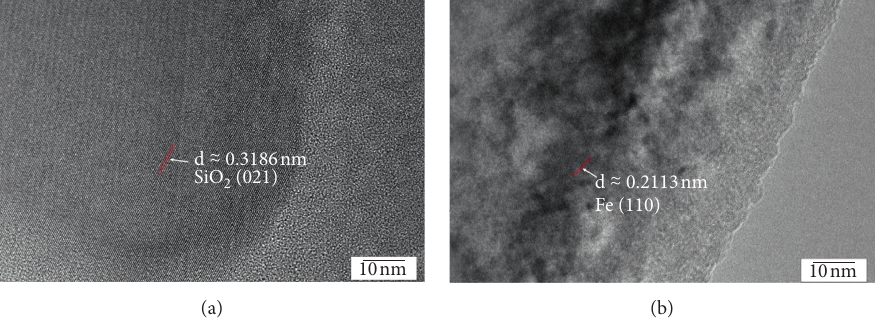
Figure 8: High-resolution transmission electron microscopy (HRTEM) image and corresponding SAED pattern of the as-cladded 2.25Cr1Mo0.25V sample made by WAAM: (a) inclusion and (b) matrix.